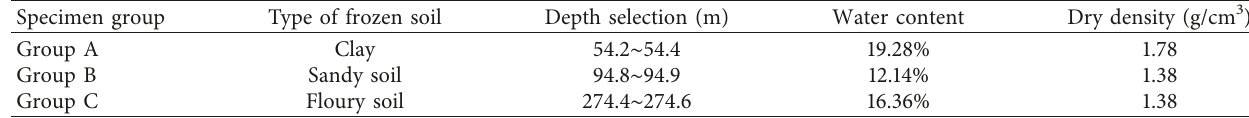
Table 1: Sampling conditions in three types of soil.